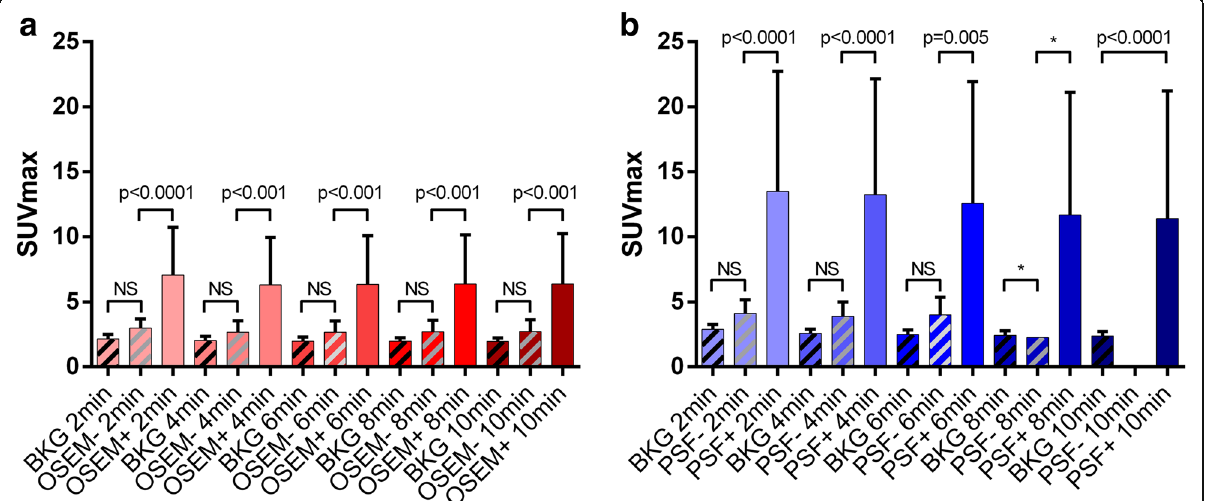
Fig. 4 Comparison of maximal standard uptake values (SUVmax) (mean, SD) between vascular background (BKG) and 18 FDG-foci suggestive of tumour detected or not on 3D-OSEM ( a ) and PSF allpass ( b ) reconstructed PET images. PSF − are lesions not detected by PSF allpass , OSEM − are those not detected by 3D-OSEM. Conversely, PSF+ are lesions detected by PSF allpass and OSEM+ are those detected by 3D-OSEM. NS: non-significant; * the number of 18 FDG-foci in the PSF − group ( n = 2) does not enable statistical analysis